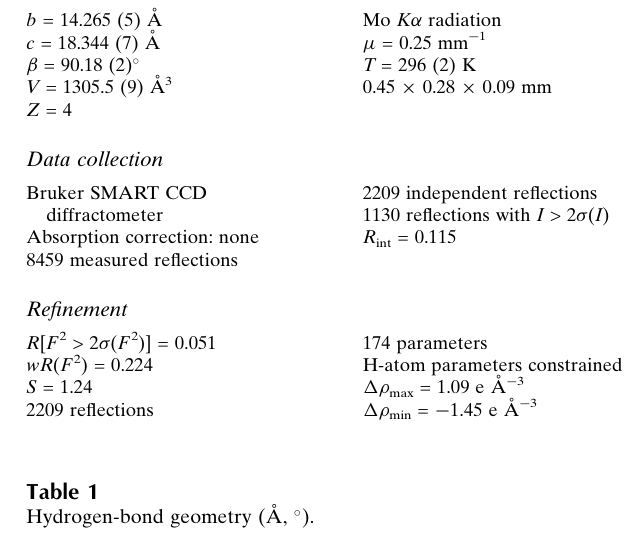
Hydrogen-bond geometry (A˚ , (cid:2)